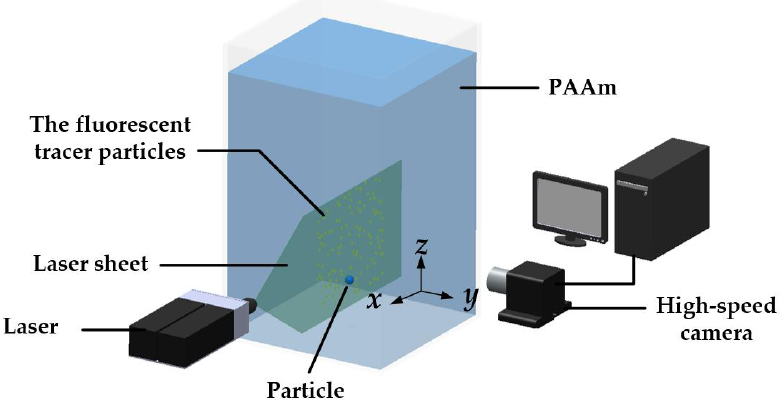
Figure 1. Schematic of the experimental setup for two side-by-side particles settling.